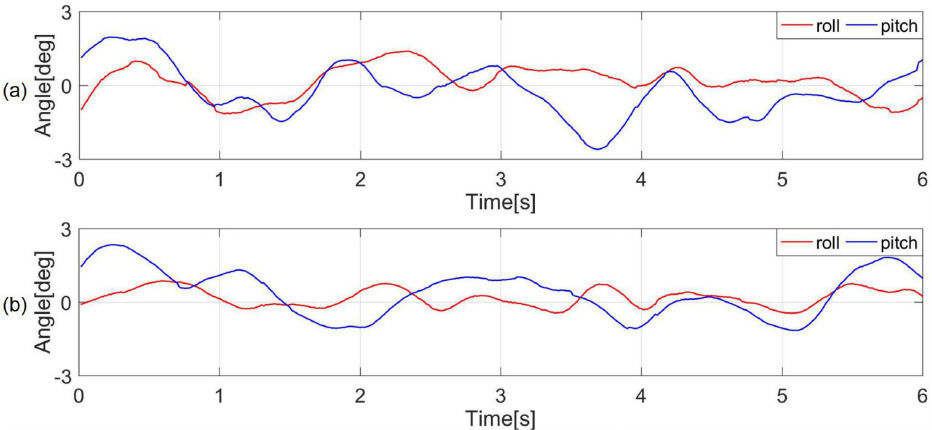
Figure 13. Experimental result of push ( a ) and pull ( b ) tasks. The graph shows roll and pitch angles of multirotor during the operation, and it corresponds to Figure